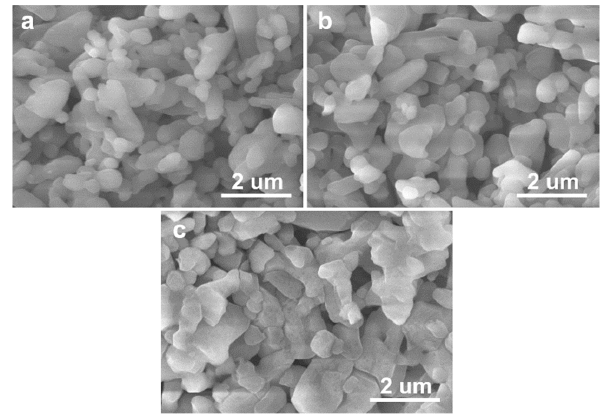
Figure 2. FESEM images of porous Al 2 O 3 ceramics sintered at 1300 °C ( a ); 1350 °C ( b ) and 1400 °C ( c ), with the Al 2 O 3 content at 30 vol.% in the ceramic slurries.